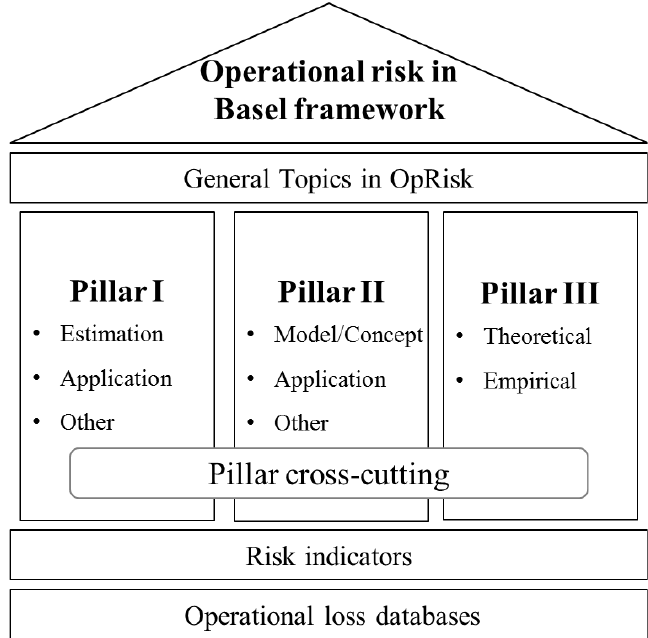
Figure 1. An overview of our categorisation’s method.